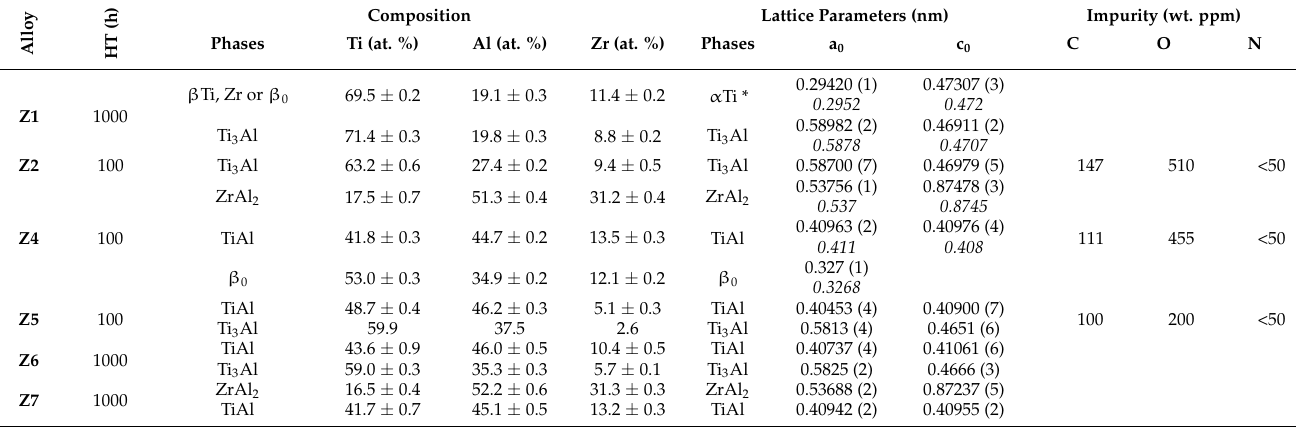
Table 3. Compositions and lattice parameters of the coexisting phases and impurity contents of samples annealed at 1000 ◦ C. Data for HT represent the duration of heat-treatments; data shown in italics are from HE-XRD; phases marked with an asterisk (*) formed during quenching. Lattice Parameters (nm) Impurity (wt. ppm)